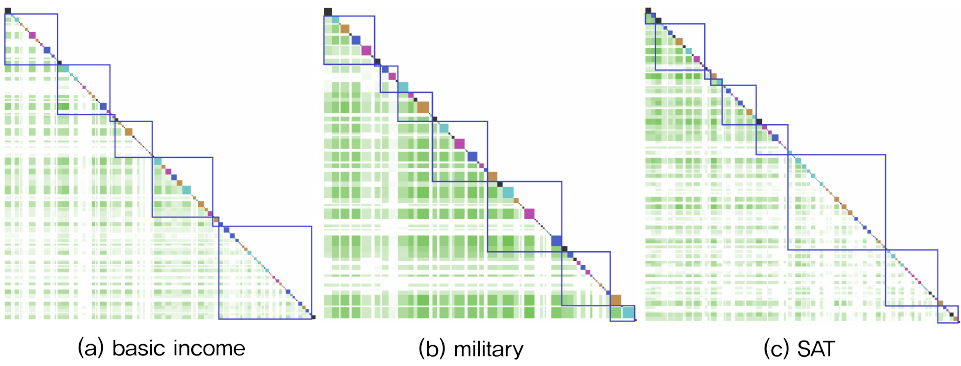
Figure 24. Results of segmenting transcripts based on topic segmentation points marked at the same location by more than three out of seven